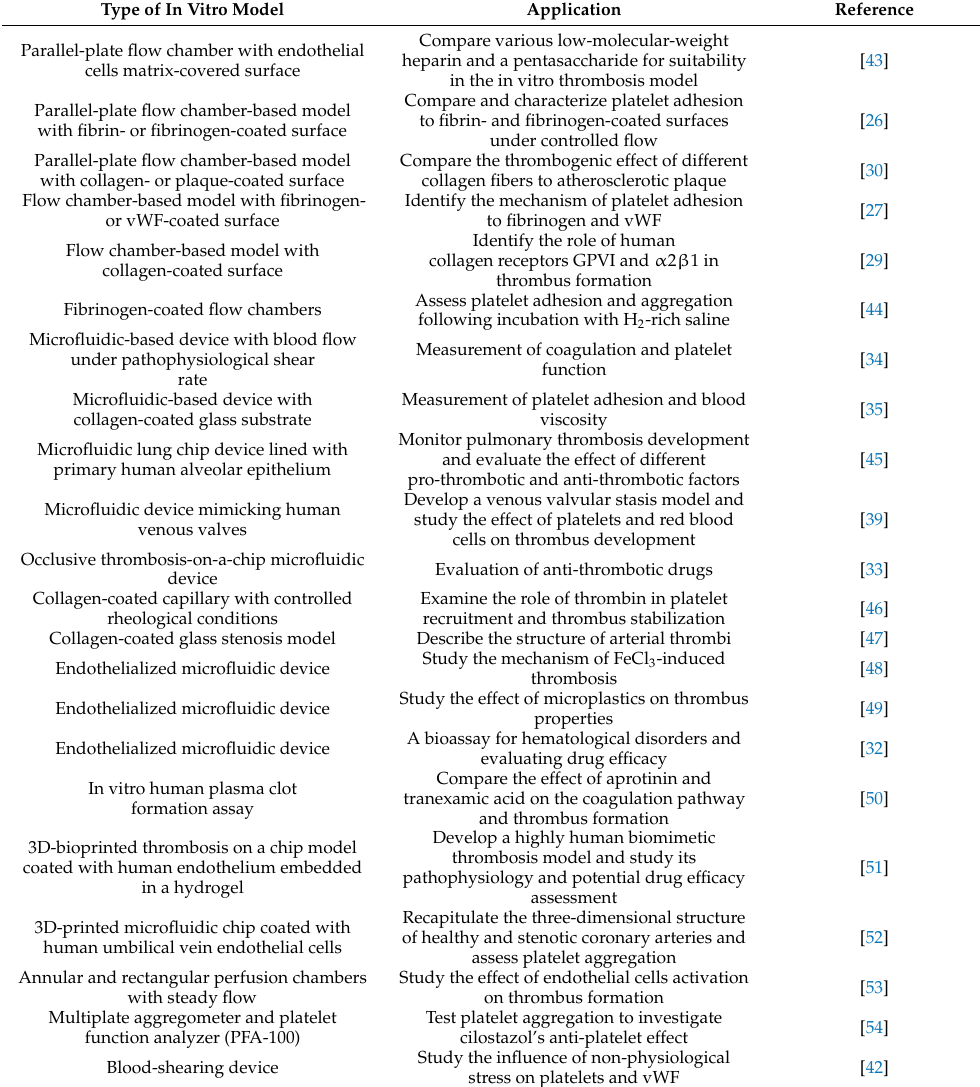
Table 1. A list of some in vitro thrombosis